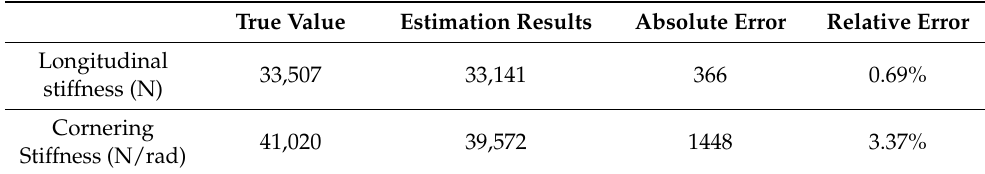
Table 3. Tire parameter estimation results and error analysis.